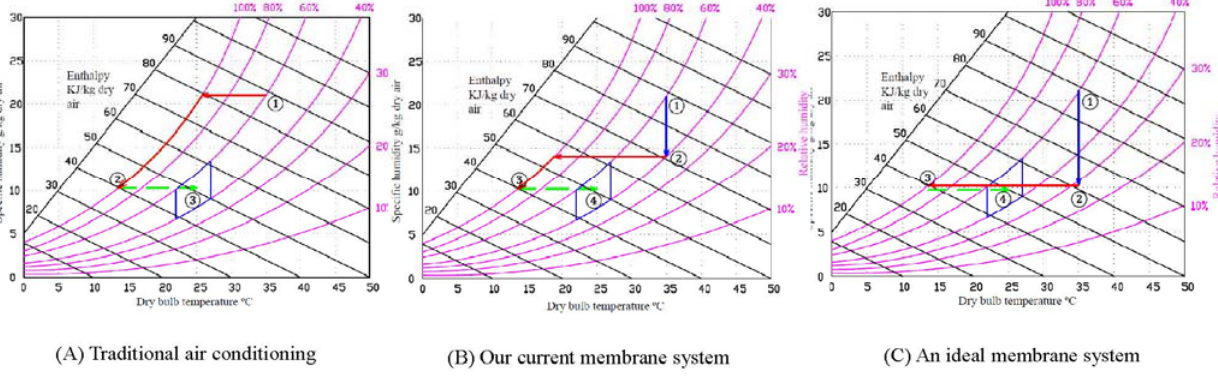
Figure 9. Comparison of energy consumption of ( A ) traditional air conditioning system without dehumidification; ( B ) air conditioning using our current membrane system; and ( C ) air conditioning using an ideal membrane